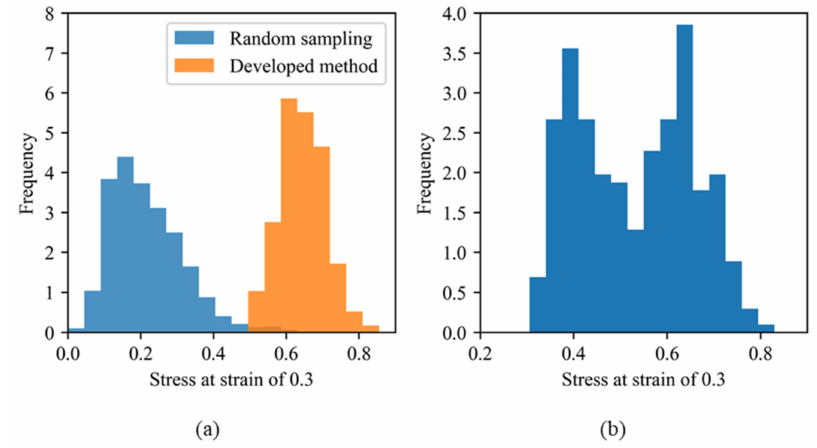
Figure 1. ( a ) Stress distributions obtained by the random sampling and the developed method in our preliminary study [30]. ( b )Stress distribution of the morphologies obtained by either method with a filler volume fraction of 20 vol.% and was used as the training data in the present study.